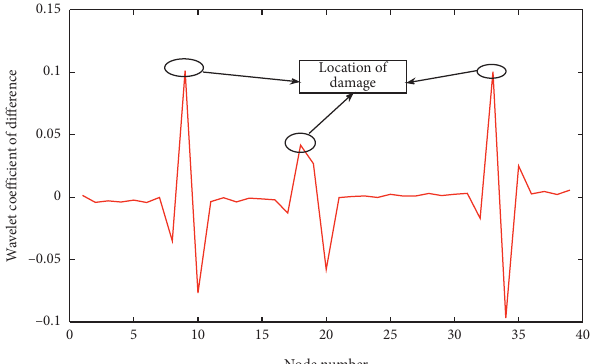
Figure 12: Wavelet coefficient difference for 20% damage in sections 9, 19, and 34.